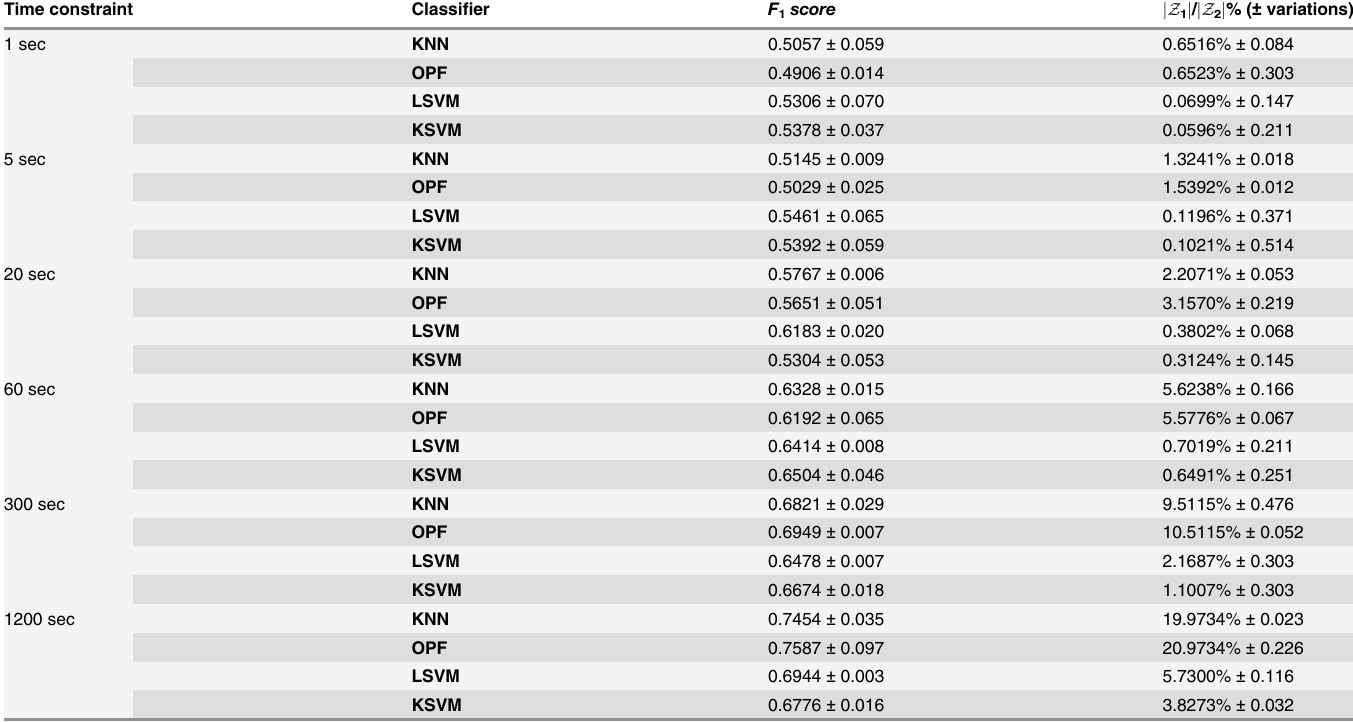
Table 9. Covertype dataset: Predictivity performance over Z 3 and final training set size, j Z 1 j as a percentual of j Z 2 j , for each classification model and learning time constraint using random selection.